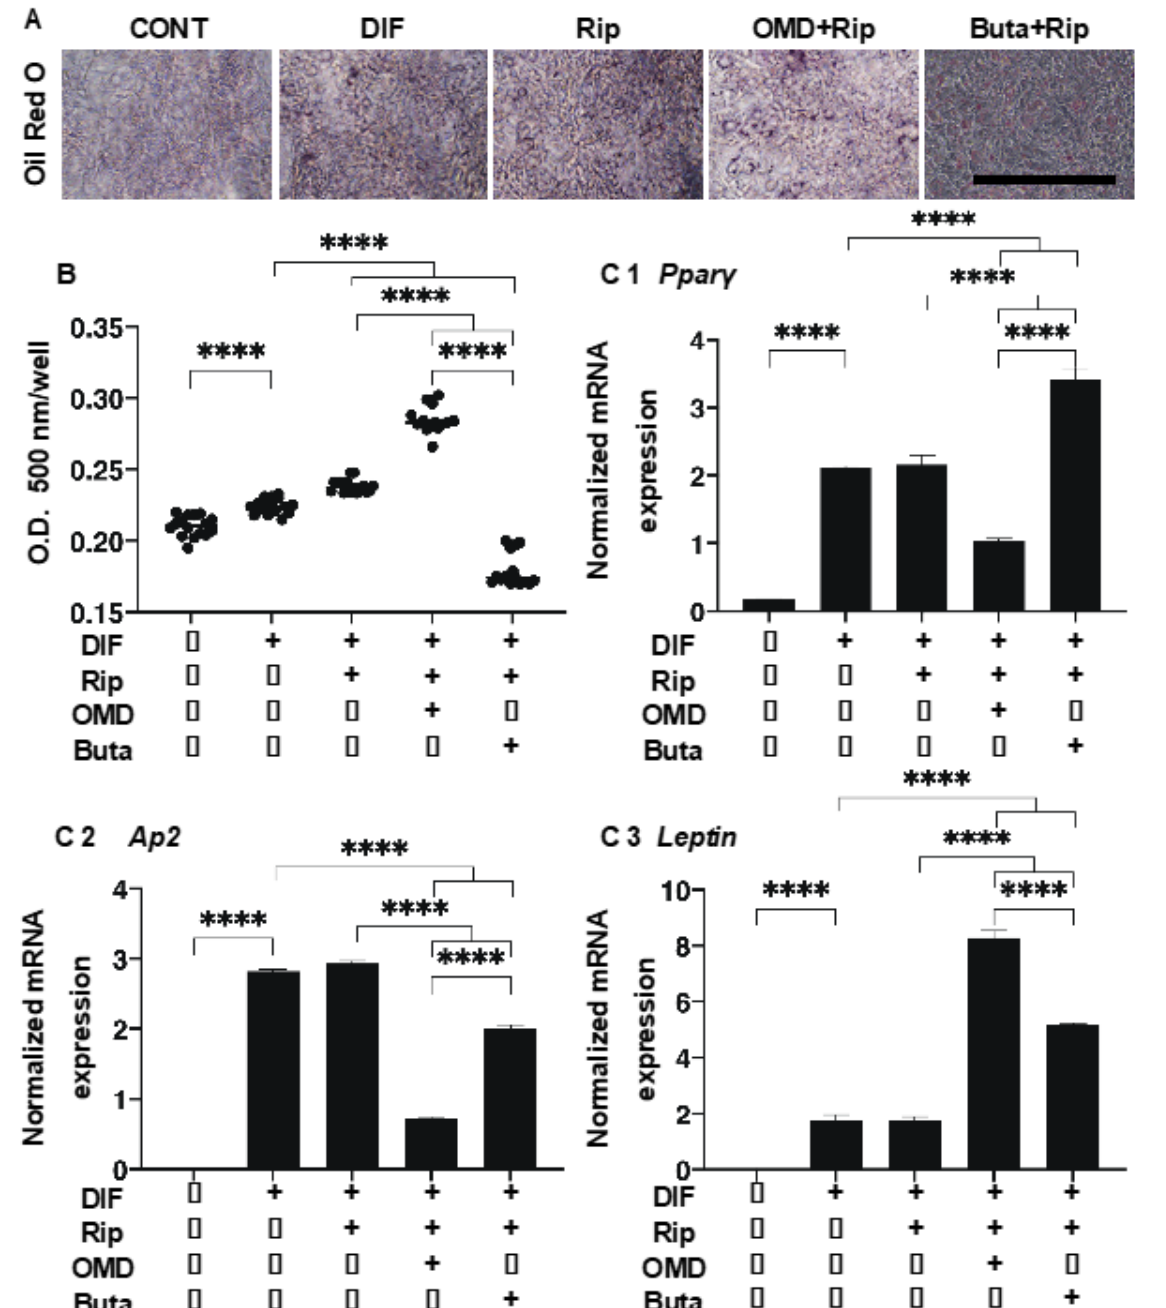
Figure 1. Additive effects of EP2 agonists to ripasudil (Rip) on the adipogenesis of 2D cultured 3T3-L1 cells. The 2D cultures of 3T3-L1 cells were prepared under several sets of conditions: preadipocytes of 3T3-L1 cells (DIF-) or their adipogenic differentiation (DIF+) with or without combinations of 10 µ M ripasudil (Rip) and EP2 agonist, 100 nM omidenepag (OMD) or 100 nM butaprost (Buta). These specimens were subjected to analysis by Oil Red O lipid staining (panel A : representative phase contrast images, scale bar: 100 µ m; and panel B : their staining intensities, O.D.) and qPCR of the master adipogenesis gene, Ppar γ , Ap2 and Leptin (panel C 1–3). All experiments were performed in triplicate using fresh preparations, each of which consisted of 5 specimens. Data are presented as the arithmetic mean ± the standard error of the mean (SEM). **** p < 0.001 (ANOVA followed by a Tukey’s multiple comparison test).